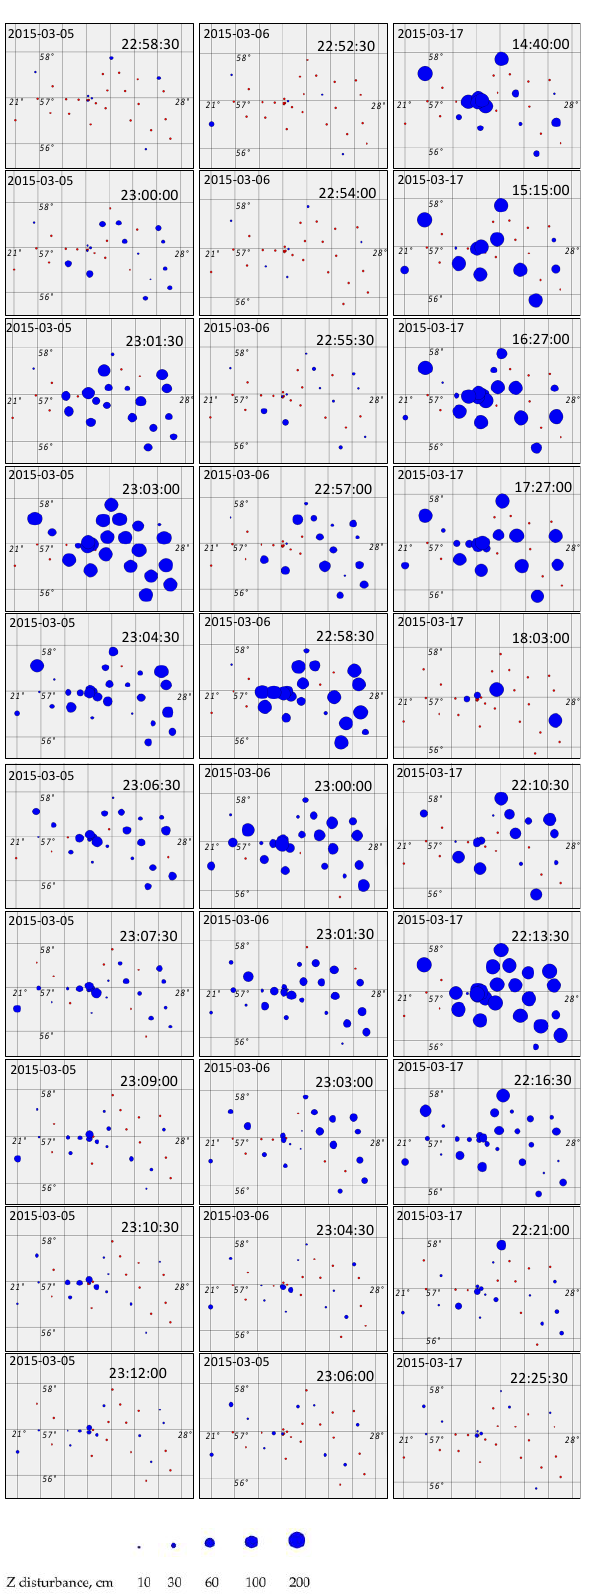
Figure 4. The time series of 30 sites involved at sequential time moments (with 1.5 min steps) on the latitude – longitude coordinate plane.